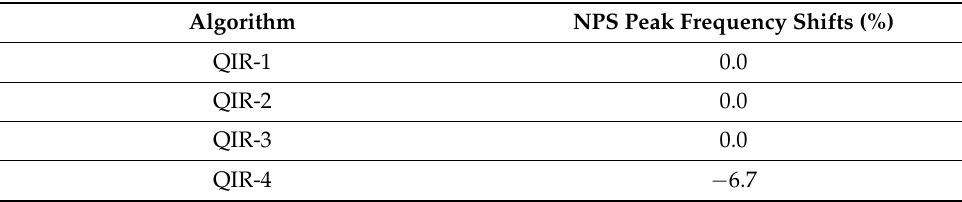
Figure 3. NPS as a function of image reconstruction. The NPS showed decreasing noise magnitude with increasing QIR level. The shape of the NPS indicated similar noise texture among reconstructions. Table 2. The NPS peak frequency shifts in percentage differences for QIR levels from 1 to 4 in comparison with QIR-off.